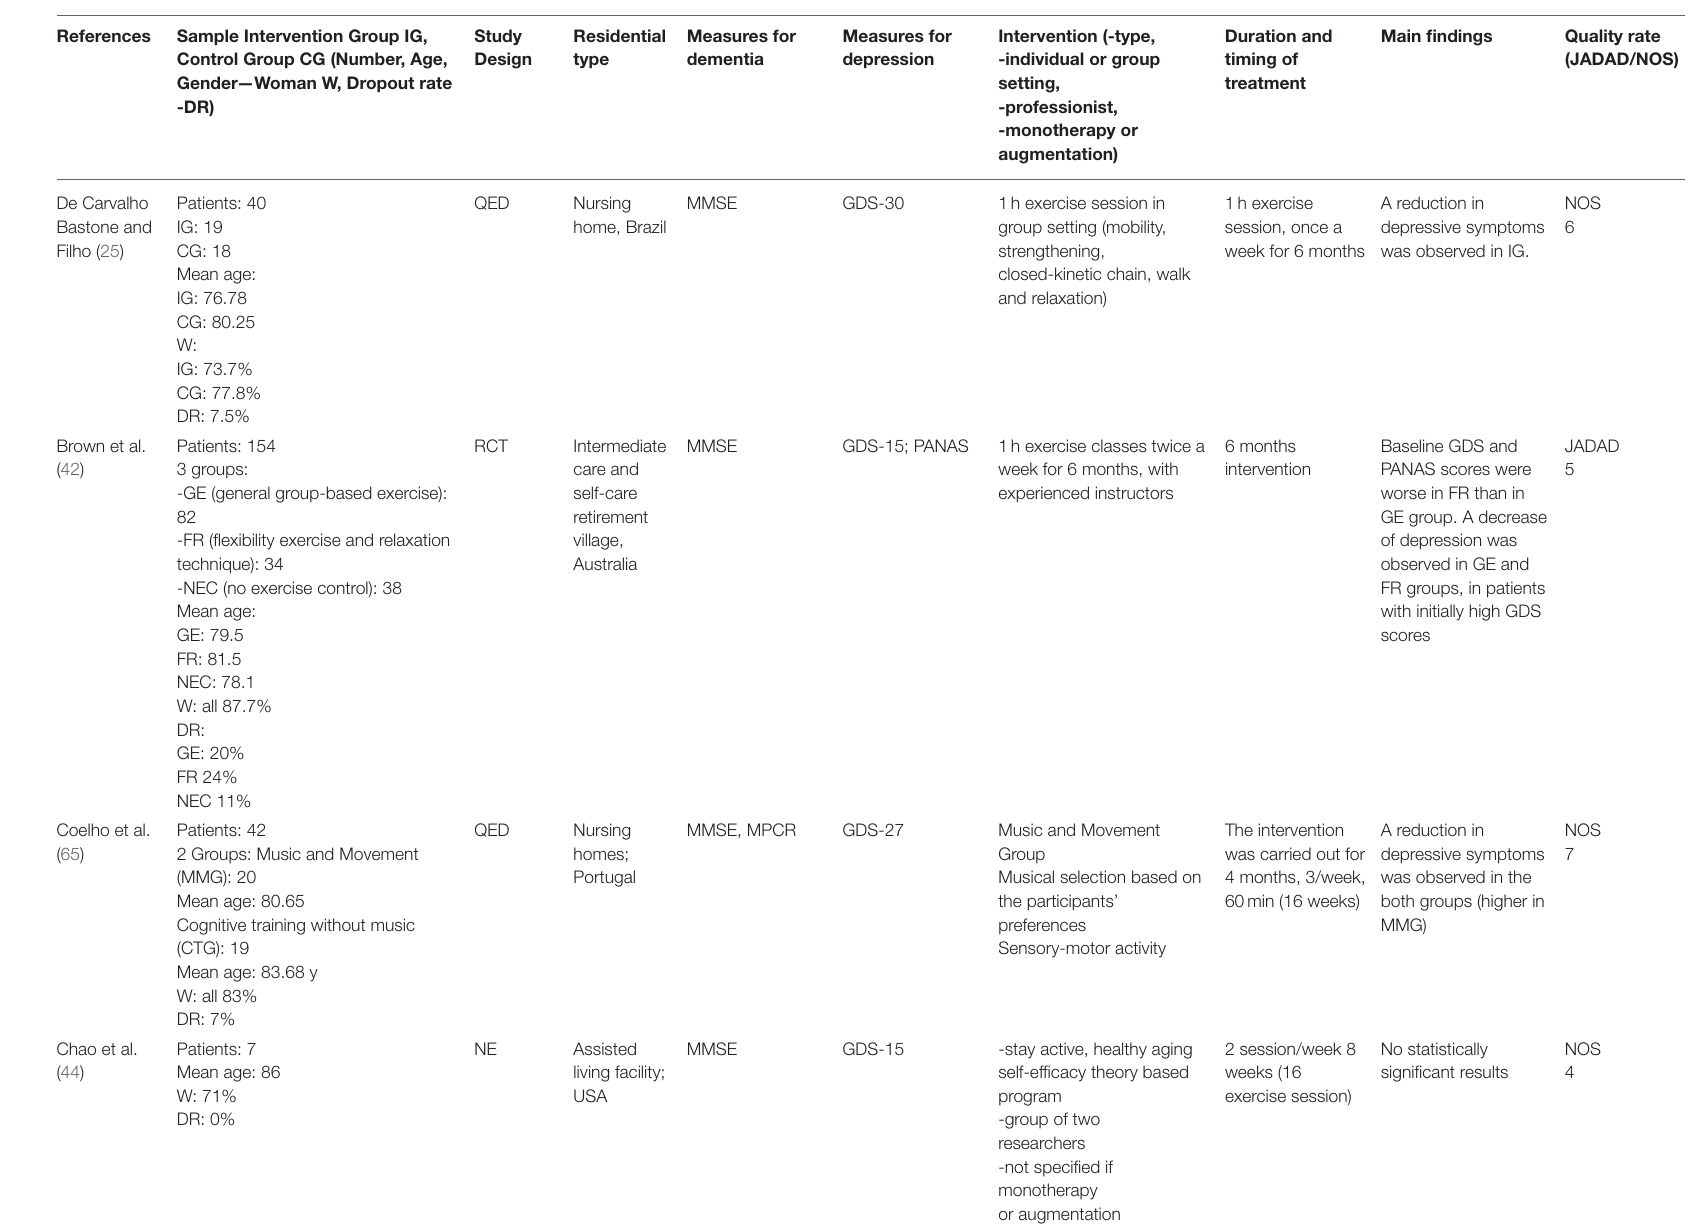
TABLE 3 | Physical exercise studies (n 9